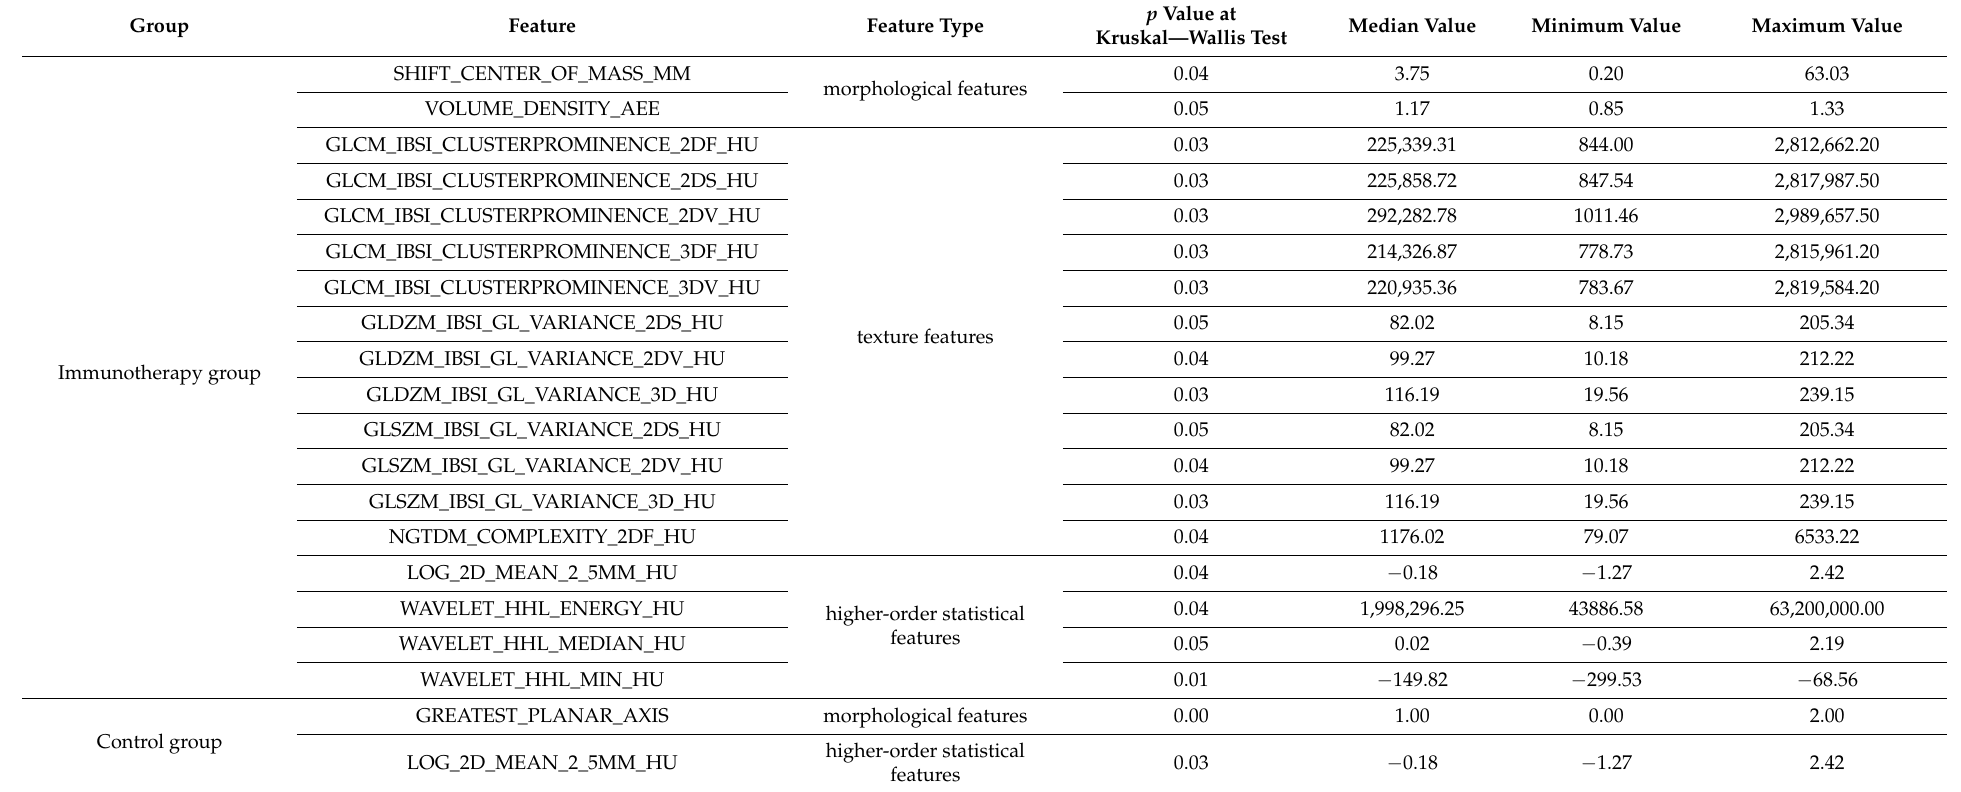
Table 4. Median and range values for textural features significant for stratifying the patients into two groups based on median cutoff of OS time (short and long time). Diagnostic performance is also reported for each significant feature, considering the optimal cutoff value obtained by ROC